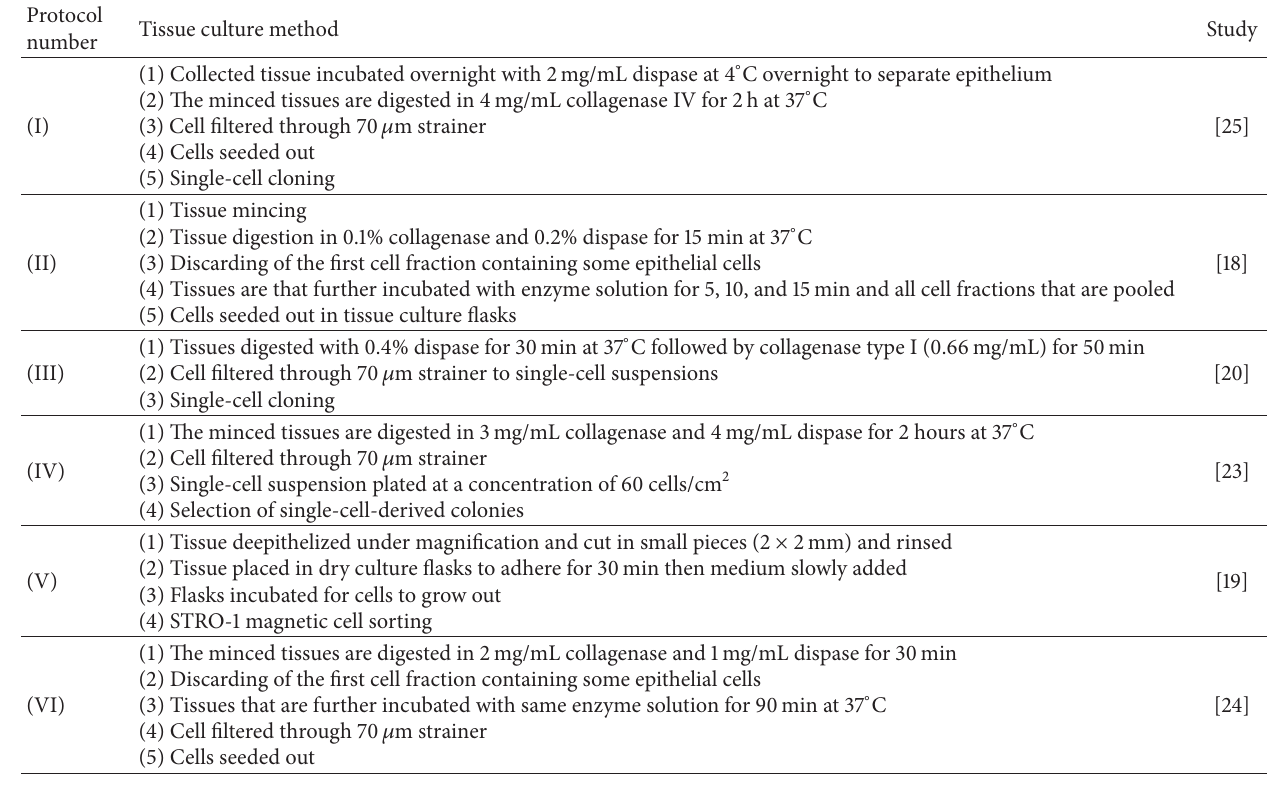
Table 1: Human G-MSCs isolation protocols.